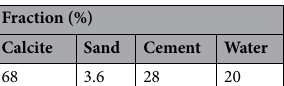
Table 1. Percentages of materials used in synthetic rocks. Reference 21 .